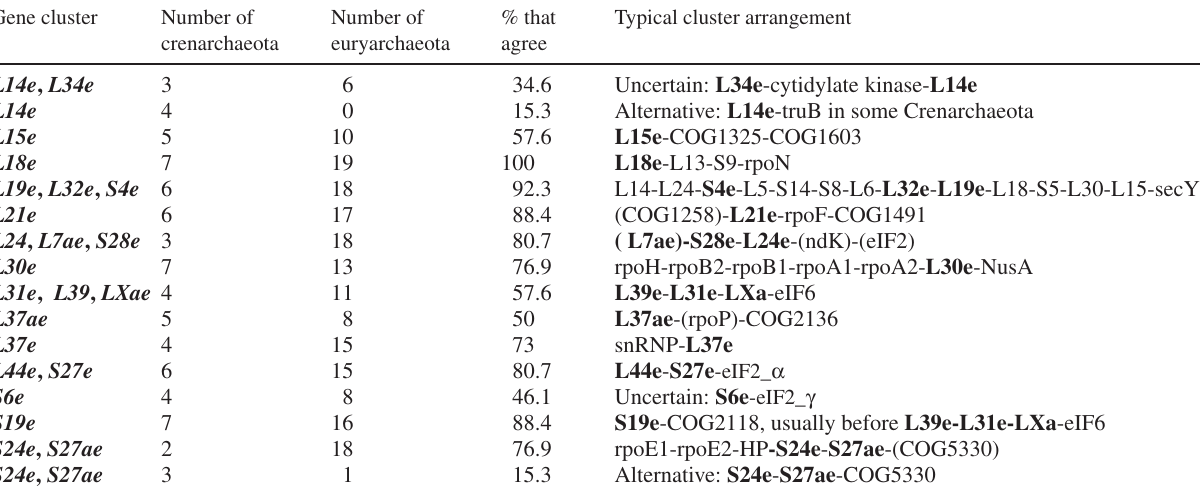
Table 1. List of common clusters containing genes for archaea-unique ribosomal proteins. The nonuniversal archaeal ribosome proteins (in bold) are shown in their most common genomic contexts. The numbers of crenarchaeota (Max = 7) and euryarchaeota (19) containing the particular ar- rangement are shown along with the total % of organisms containing that version. If the cluster did not completely meet our criteria (L14e, L7ae, and S6e), it is listed as uncertain. In two cases (L14e and L34e; S24e and S27ae), alternative but similar arrangements are shown. Gene/Protein names inside parentheses are not always present in the cluster and hence do not form the core of the cluster. Gene